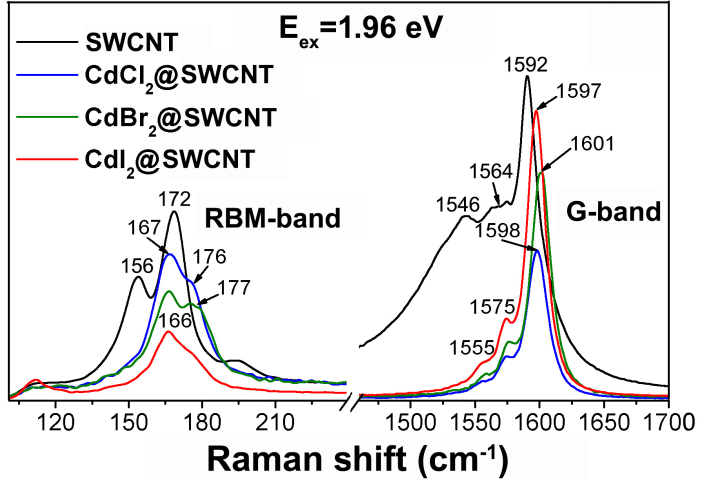
Figure 4. The RBM and G-bands of Raman spectra of the pristine SWCNTS and nanotubes filled with cadmium chloride, cadmium bromide and cadmium iodide acquired at laser energy 1.96 eV.